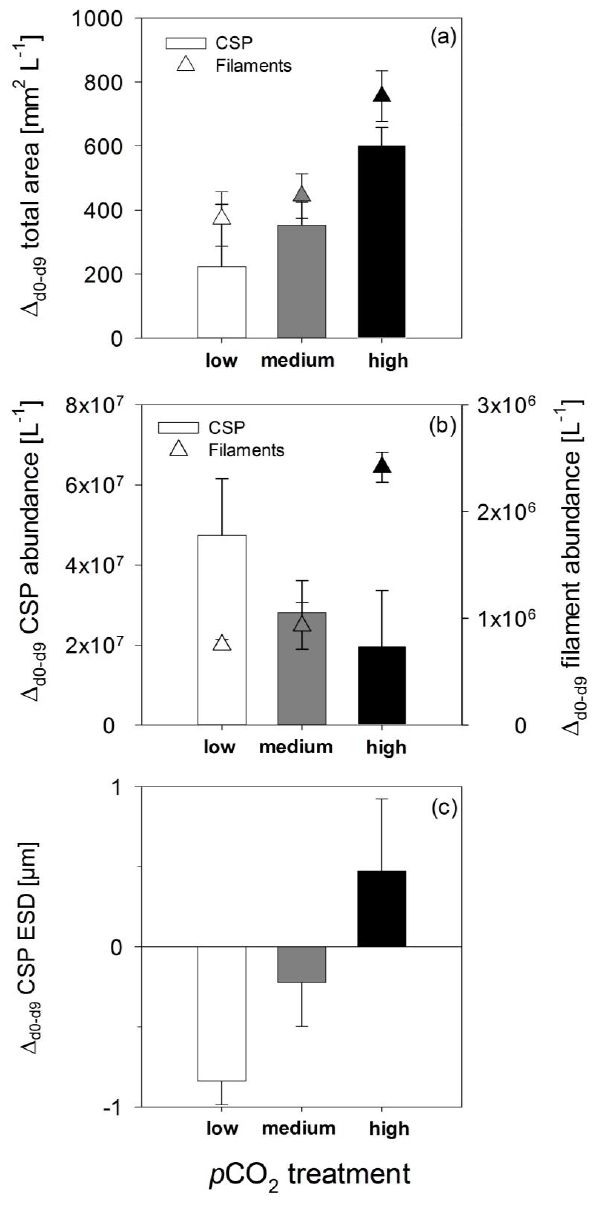
Fig. 5. Variation of the filaments and CSP during the growth phase (day 0 to day 9) in the low (white), medium (grey) and high (black) p CO 2 treatments: (a) total area of the filaments and CSP; (b) fila- ment and CSP abundance; (c) equivalent spherical diameter (ESD) of CSP. Symbols and bars display the mean of three replicates with standard